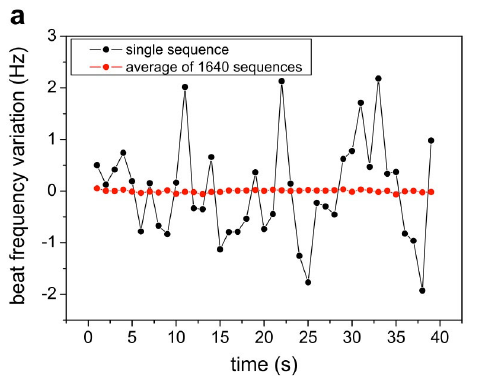
Figure 5. The experimental frequency shift reported in Figure 9a of ref. [98] (courtesy Optics Communications). The black dots give the instantaneous signal, the red dots give the signal averaged over 1640 sequences. For a laser frequency ν 0 = 2.8 · 10 14 Hz, a ∆ ν = ± 1 Hz corresponds to a fractional value ∆ ν / ν 0 of approximately ± 3.5 · 10 − 15 .